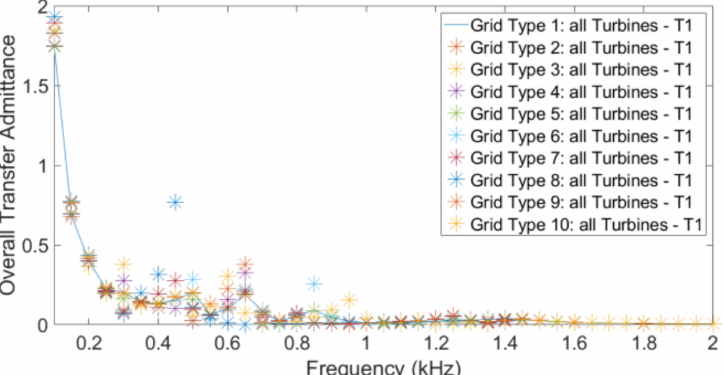
Figure 21. Impact of public grid impedance on overall transfer admittance (A/V) from turbine to public grid: 5-turbine wind power plant.